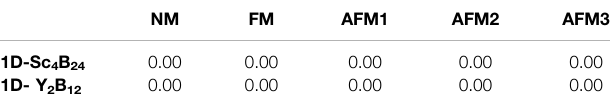
TABLE 2 | Relative energies of 1D- Sc 4 B 24 and 1D-Y 2 B 12 nanowires with various magnetic con fi gurations (in eV).